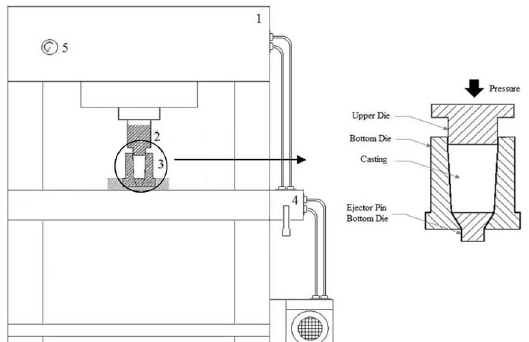
Figure 2. Schematic representation of the squeeze casting experimental solidification setup: (1) hydraulic press; (2) upper die; (3) cylindrical mold; (4) Hydraulic pressure